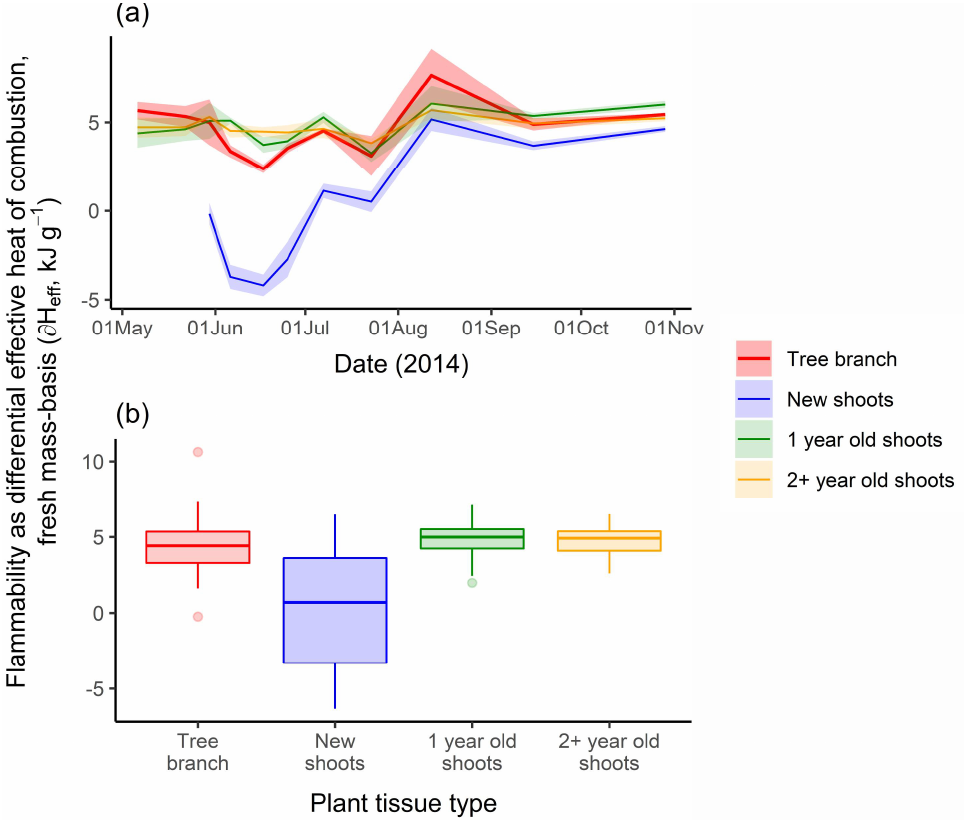
Figure 4. Seasonal variation in live fuel flammability expressed as differential effective heat of combustion ( ∂ H eff ): ( a ) Time series. Red, blue, green, and orange lines represent tree branch, new, 1 year − , and 2+ year-old shoots respectively. Standard error is shown as same-color shadow around each line. Flammability of new shoots stayed substantially negative from late-May until late-June; ( b ) Box plot of seasonal variation in ∂ H eff for tree branch, new, 1 year − , and 2+ year-old shoots. A horizontal line within the box (the interquartile range, IQR) indicates the median. Whiskers are shown at 1.5 IQR. Circles indicate observed values outside of the 1.5